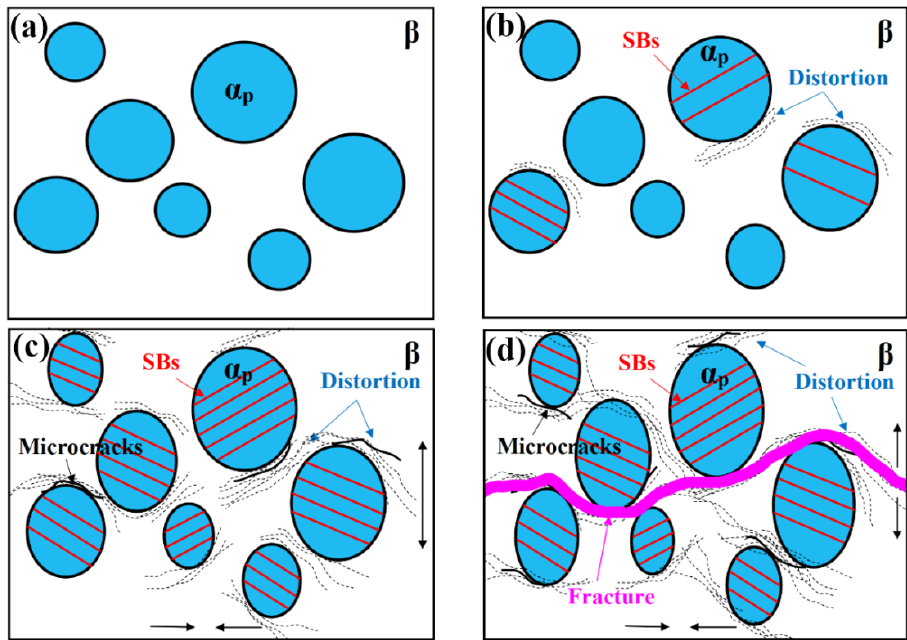
Figure 13. Schematic mechanism showing the evolution of bimodal microstructure during in situ stretching; ( a ) the initial microstructure; ( b ) at a relatively low strain; ( c ) at a relatively high strain; ( d ) schematic mechanism of deformation of bimodal samples after fracture.